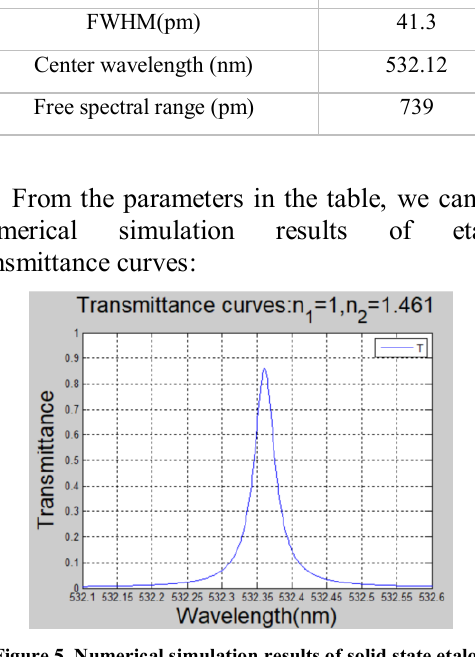
Figure 5 Numerical simulation results of solid state etalon transmittance curves